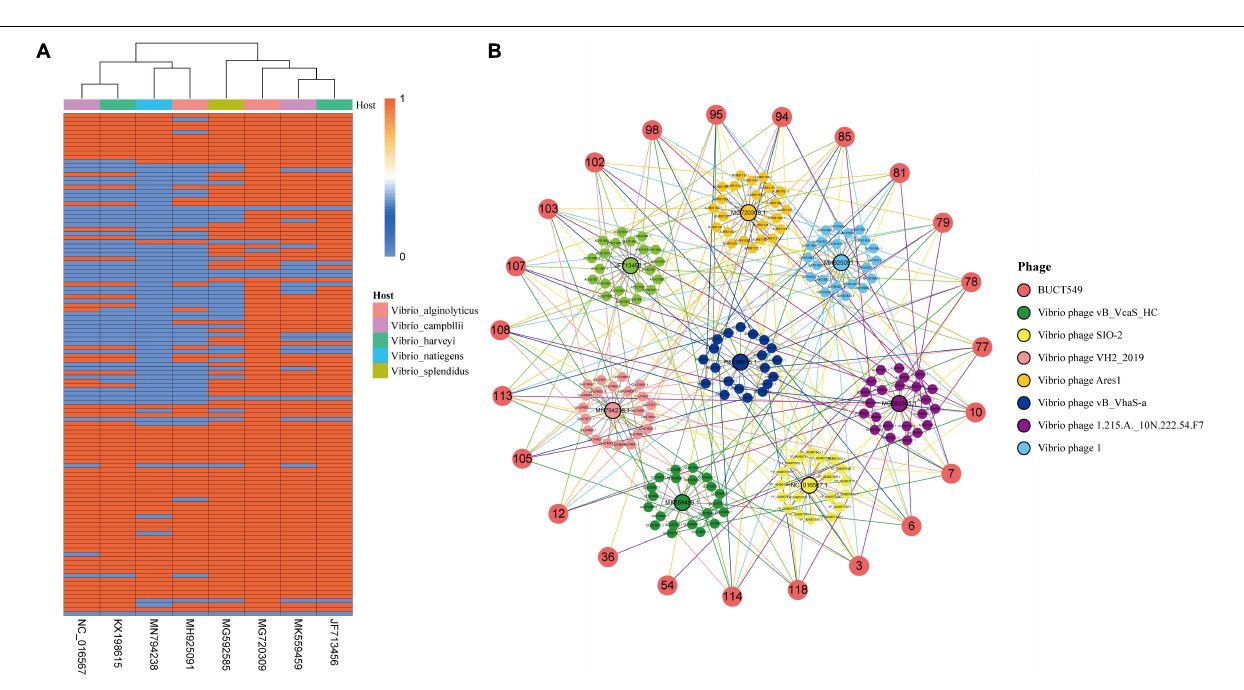
Frontiers in Microbiology |